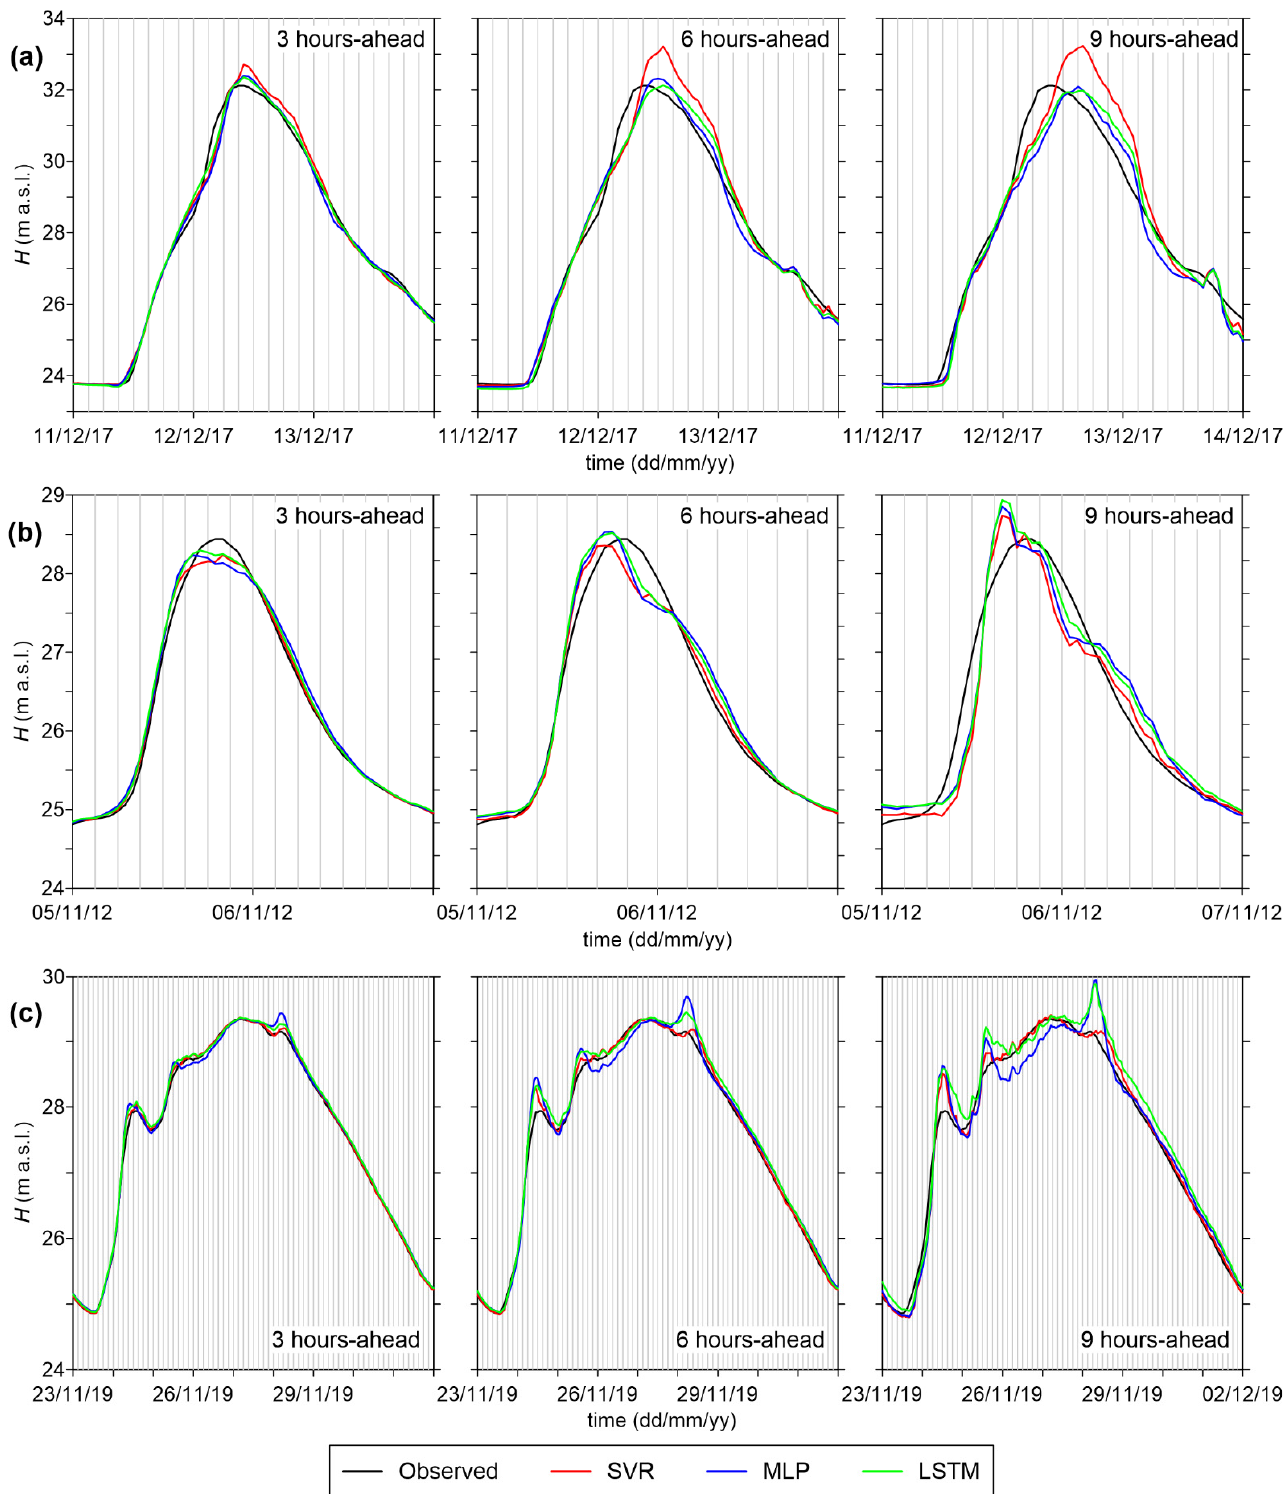
Figure 9. Comparison of observed water levels in Colorno with the forecasted values by SVR, MLP, and LSTM models for the time lags of 3, 6, and 9 h: ( a ) event of 11–14 December 2017 (large Parma River flood); ( b ) event of 5–7 November 2012 (medium Parma River flood); ( c ) event of 23 November–2 December 2019 (Po River flood). In all plots, vertical grid lines are spaced every 3 h, and the time axis is limited in order to improve readability.